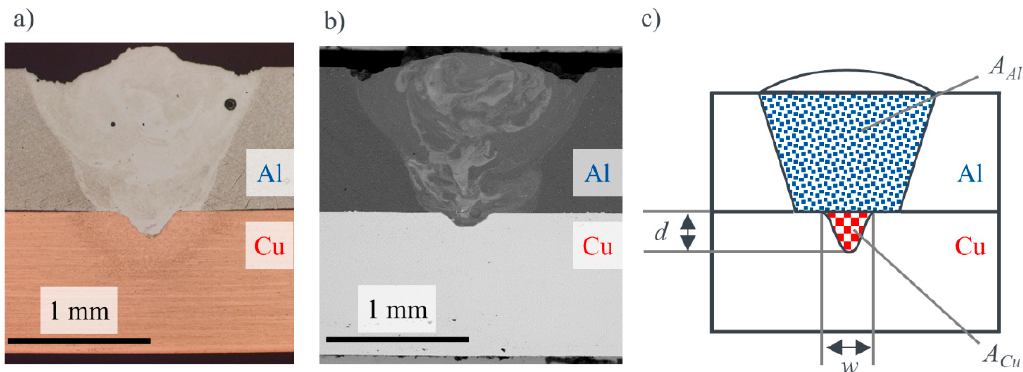
Figure 2. Images of typical cross-sections of welds produced by unmodulated rectilinear welding, optical microscopy ( a ) and SEM imaging ( b ); parameters: P = 2 kW; v feed = 6 m/min; λ laser = 1.08 µm; d f = 280 µm; z f = 0 mm, z R = 5 mm; ( c ) sketch of a typical cross-section with indication of the analyzed geometrical quantities: welding depth d into Cu, seam width w at interface, and fused areas A Al and A Cu of aluminum and copper, respectively.